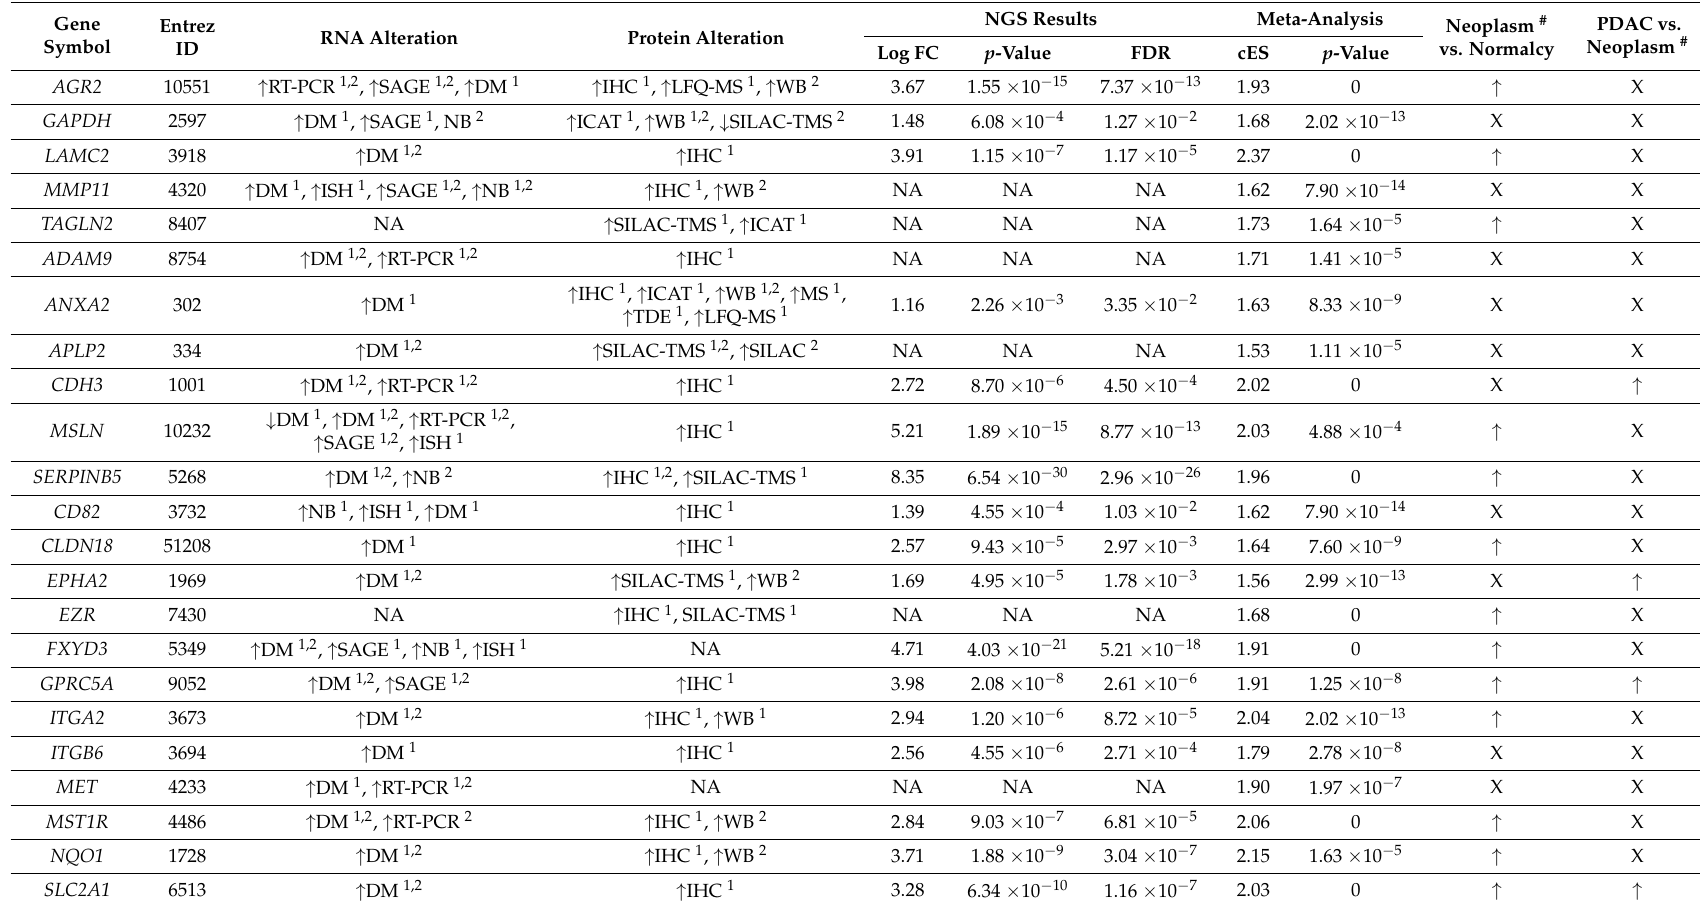
Table 1. Literature- and experiment-based validation of the 23